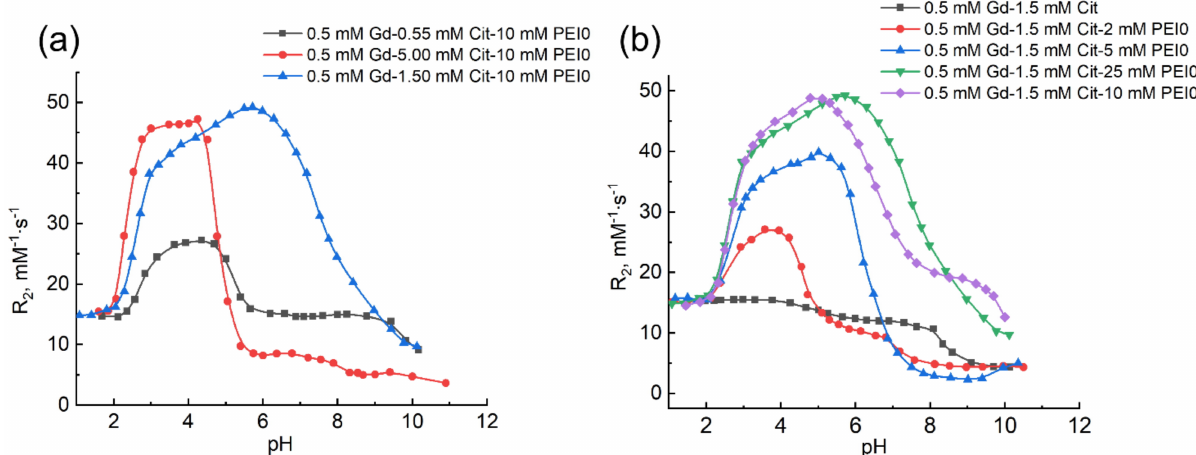
Figure 3. Dependence of the relaxation effectiveness of the solutions containing Gd 3+ ions, PEI0, and citric acid on the acidity of medium at various contents of ( a ) citric acid and ( b ) PEI. C Gd(III) 0.5 mM, C PEI 0–25 mM, C H4L 0–5